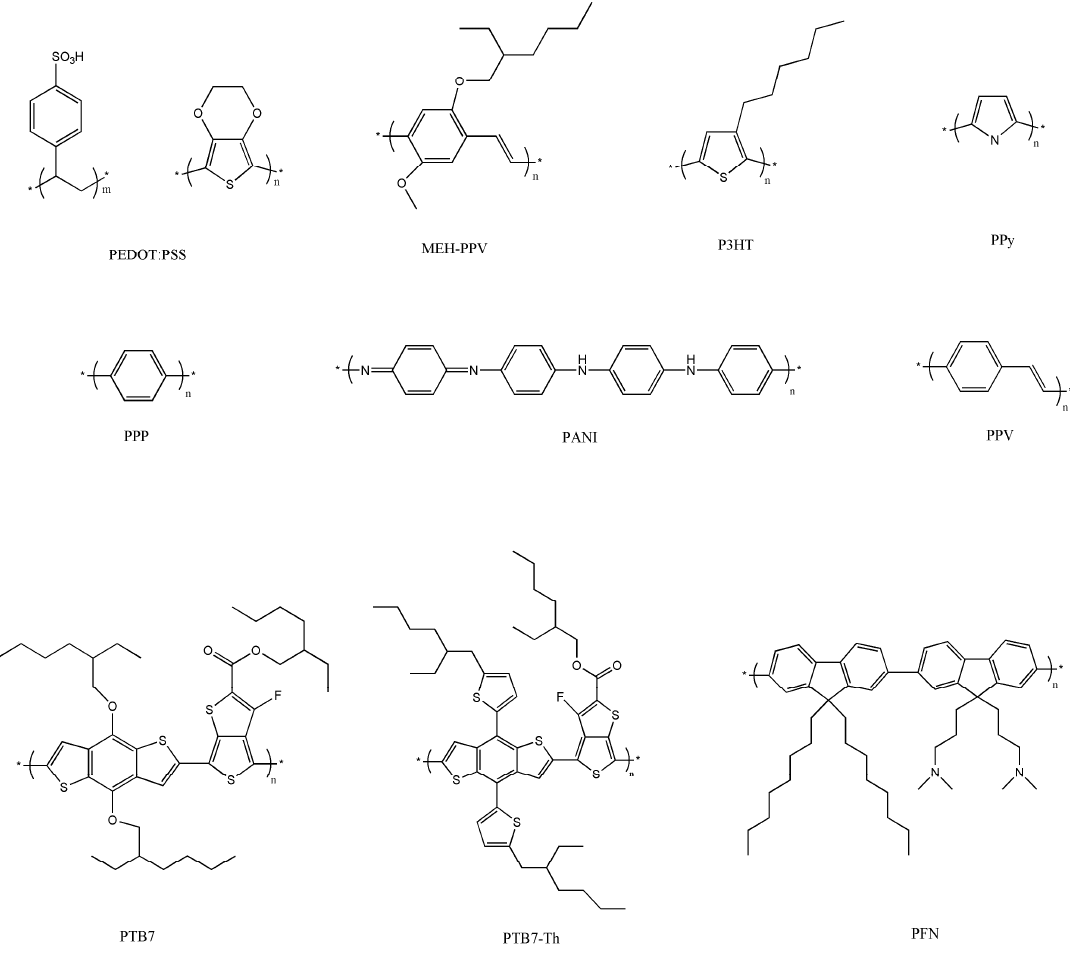
Figure 1. Chemical structure of conjugated polymers typically used in PSCs.